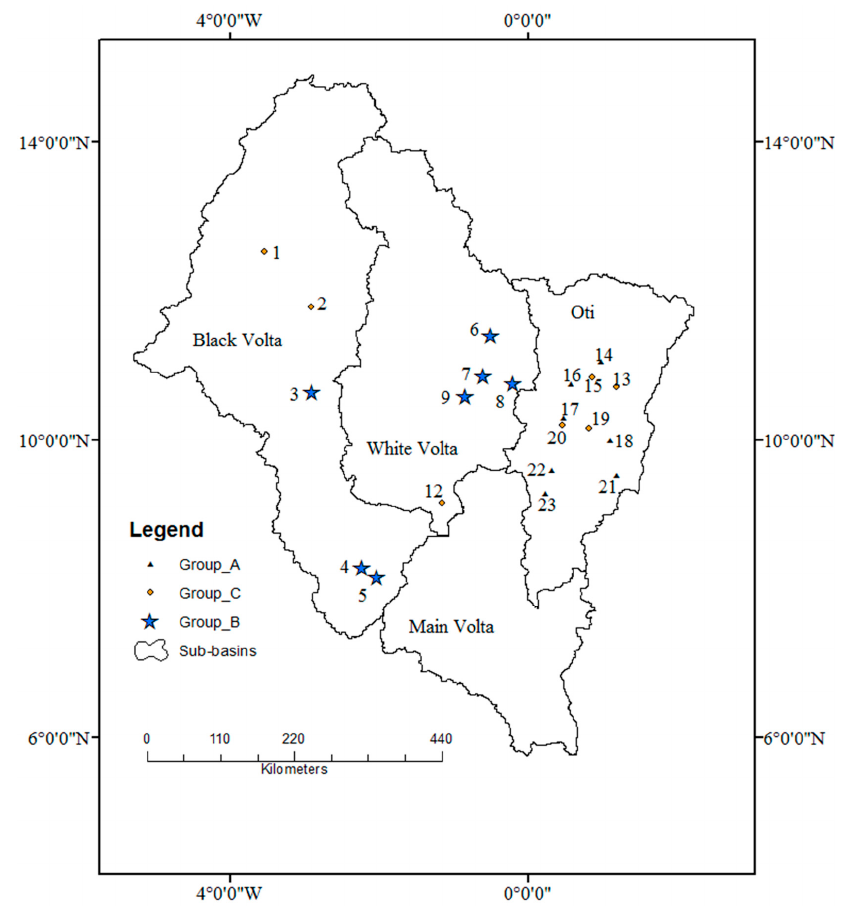
Figure 4. Location of the final homogeneous groups (for the site characteristics; please see Table 3).